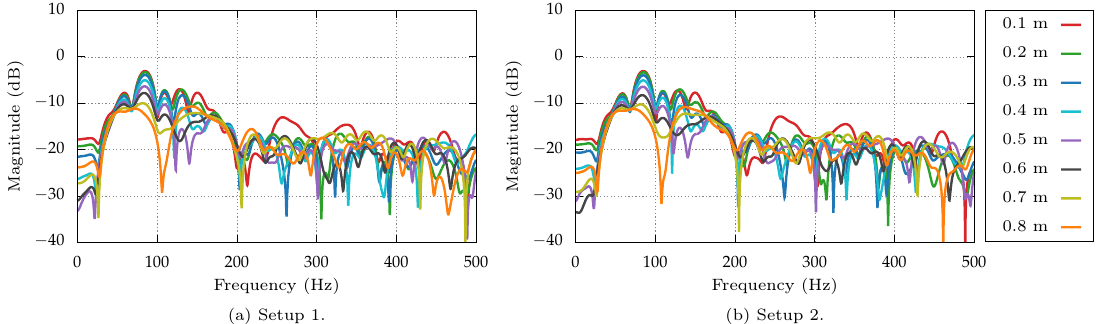
Figure 5. The amplitude functions of the frequency functions of the impulse response estimates for the primary paths with the error microphone adjacent to the top casing panel.